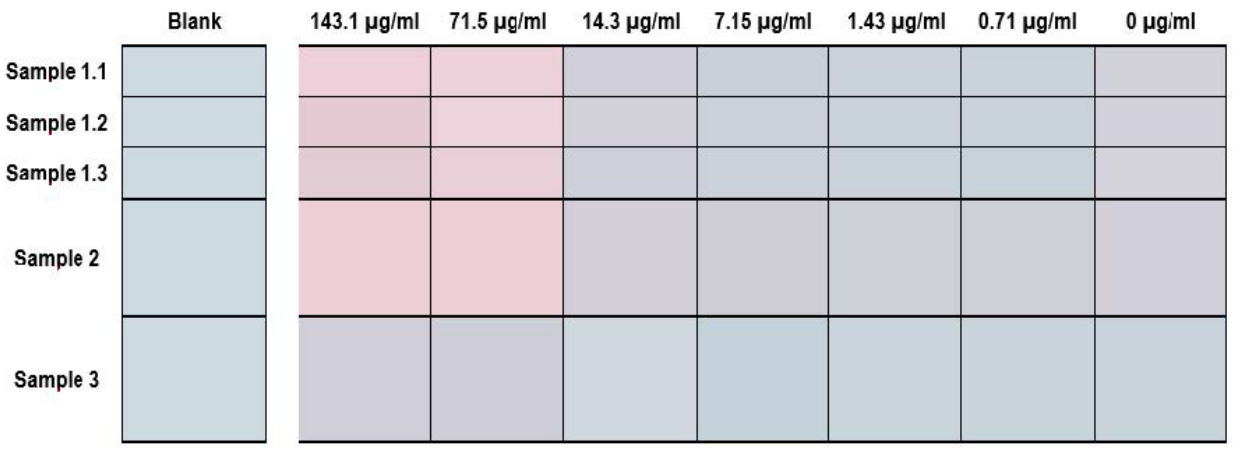
Figure 4. RGB color simulation obtained from experimental L*a*b* parameters corresponding to different lysozyme concentrations in urine. Blank samples have no urine and no lysozyme.